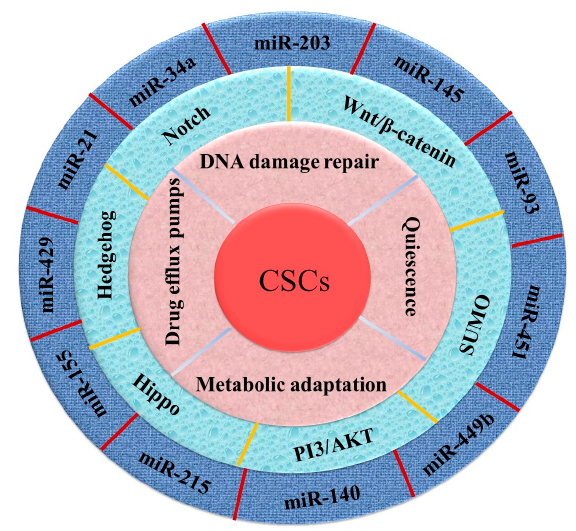
Figure 1. The features represent special characteristics, crucial signalling pathways and associated miRNAs of cancer stem cells (CSCs) in causing therapy resistance in colorectal carcinoma.